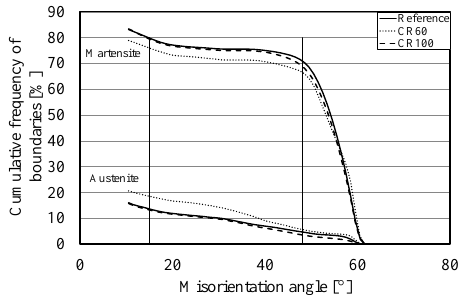
Figure 4. The curves show the cumulative frequency of martensite boundaries for misorientation angles between 10.5° and 63°. The higher curves indicate the martensite boundaries and the lower curves show the parent austenite boundaries.